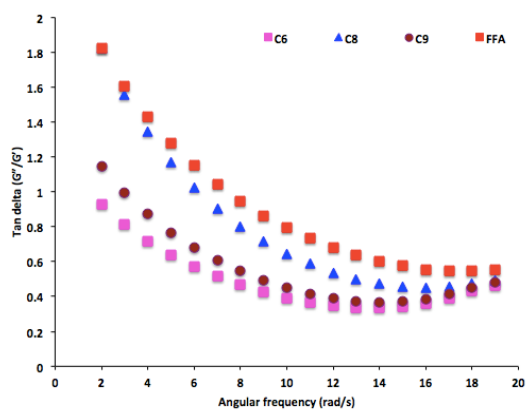
Figure 8. Tan delta (G ″ /G ′ ratio) of PHA polymers synthesized by P. putida LS46123 grown on: C6, Hexanoic acid; C8, Octanoic acid; C9, Nonanoic acid; and FFA, biodiesel ‐ derived free fatty acids (REG ‐ FFA).